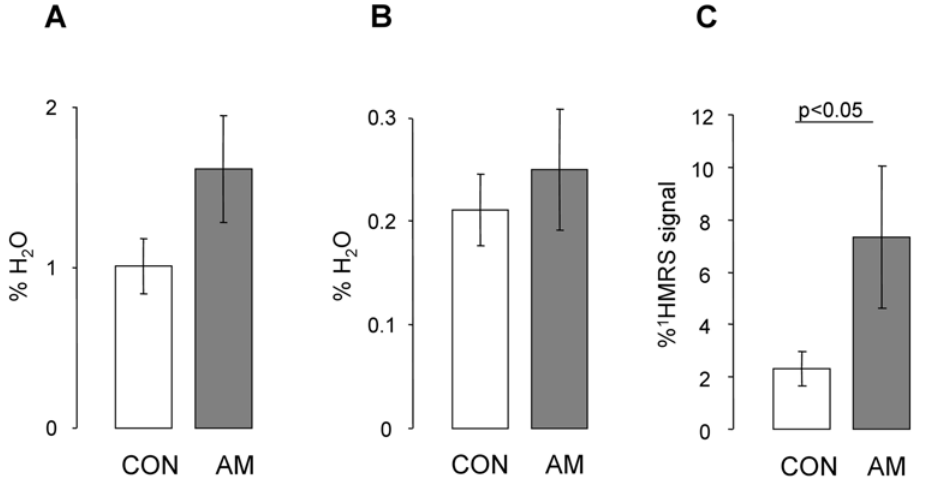
Figure 2. Ectopic lipid deposition: (A) in M.soleus (IMCLs), (B) M.tibialis ant. (IMCLt) and (C) in the liver (HCL) (p , 0.05).